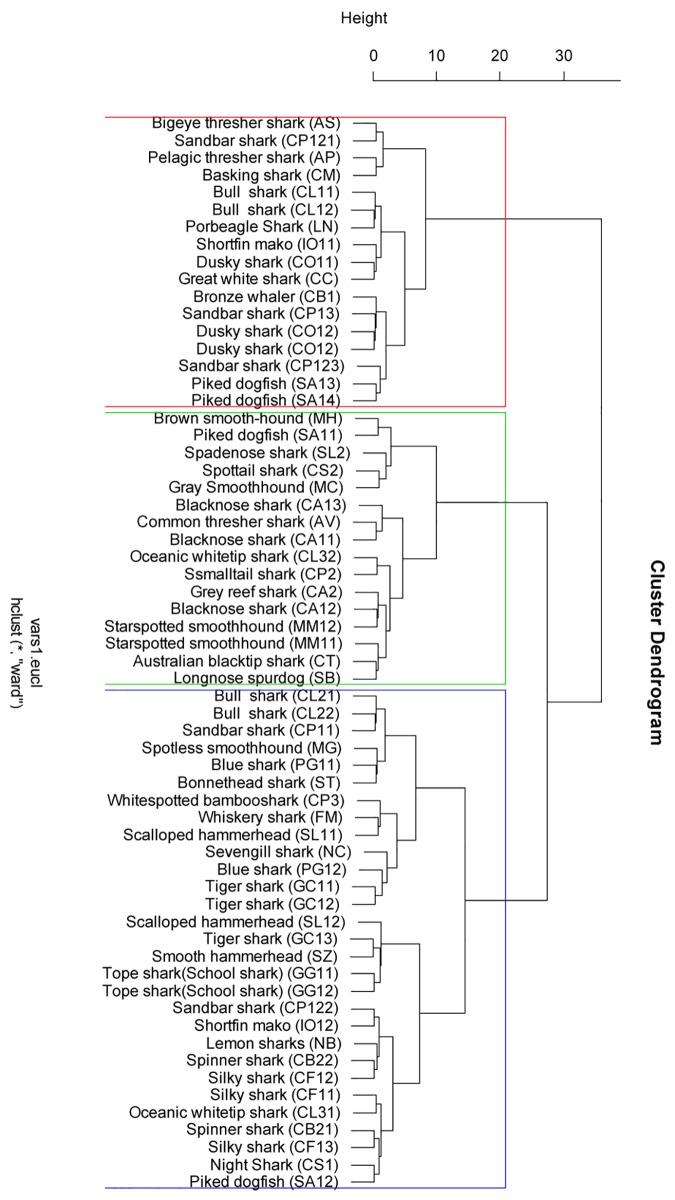
Dendrogram from a cluster analysis of seven vital parameter of 62 stocks from 38 species of sharks.The grouping shows similarities in life history traits among species and stocks from scenario 1.